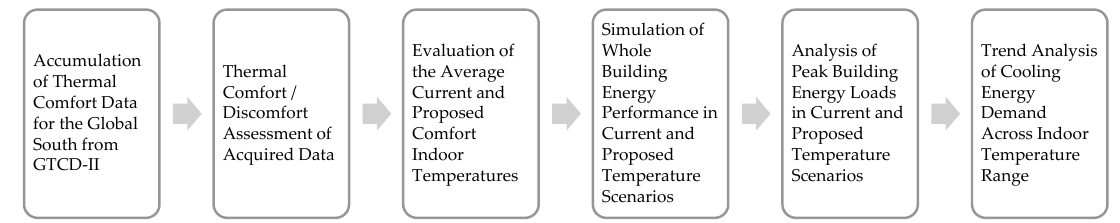
Figure 1. Summarized research steps flowchart highlighting the key phases carried in the compilation, analysis, and evaluation of the research.